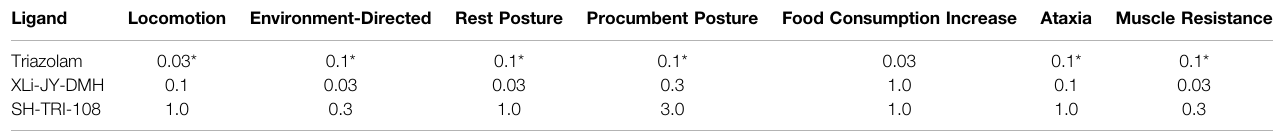
TABLE 6| Potenciesdeterminedbyminimumeffective dose(MED,mg/kg) forinductionofobservablebehavioraleffectsand fromhands-onassessment followingtriazolam and triazolobenzodiazepines in squirrel monkeys (N (cid:1) 4).